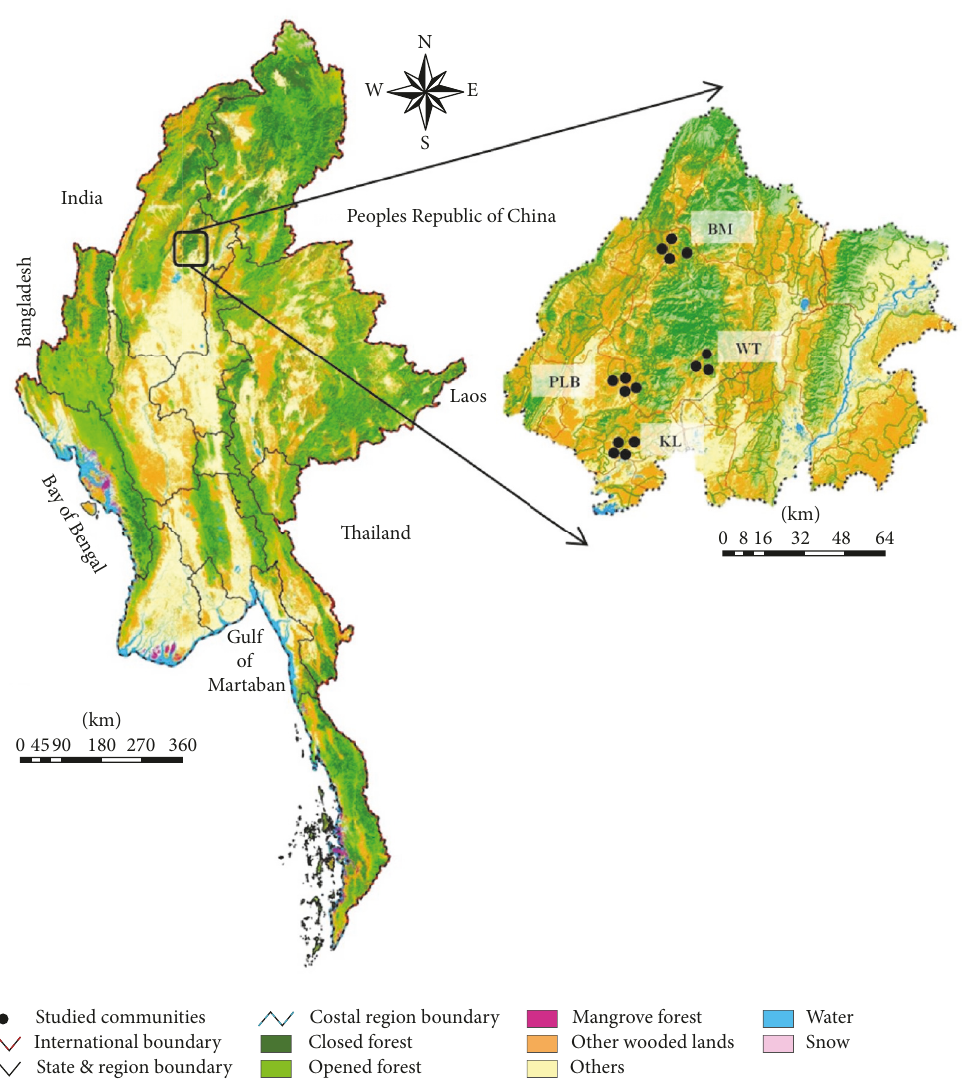
Figure 1: Location of studied communities. Source: Katha District Forest Department, 2015